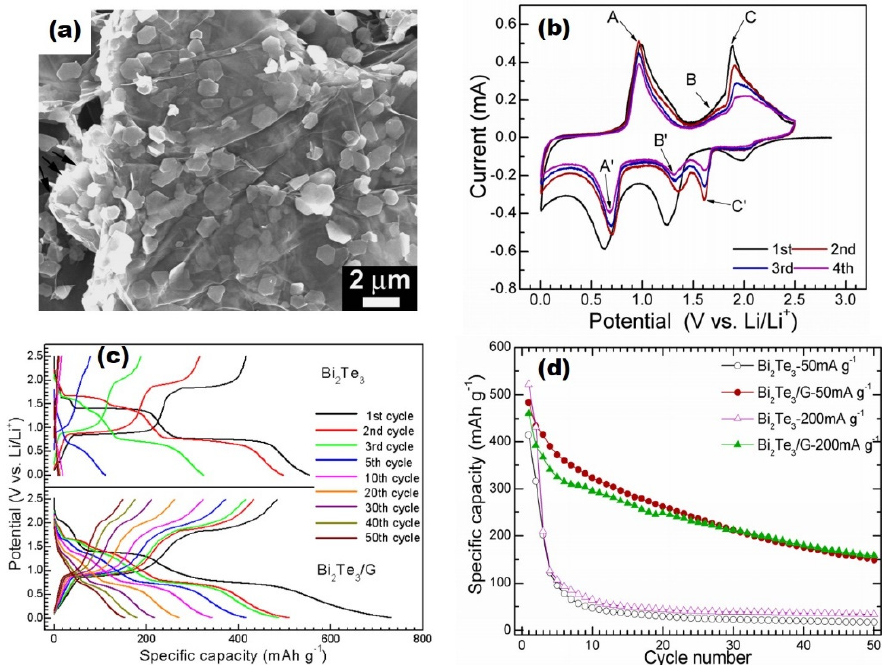
Figure 7. ( a ) SEM image of Bi 2 Te 3 nanoplates and graphene nanocomposites, ( b ) Cyclic voltammetry at 100 mAg − 1 . ( c ) Galvanostatic charge-discharge performance of bare Bi 2 Te 3 and Bi 2 Te 3 / G, ( d ) Cycling performance of Bi 2 Te 3 and Bi 2 Te 3 / graphene composites at two di ff erent current rates [78]. Reproduced with permission, copyright 2012,